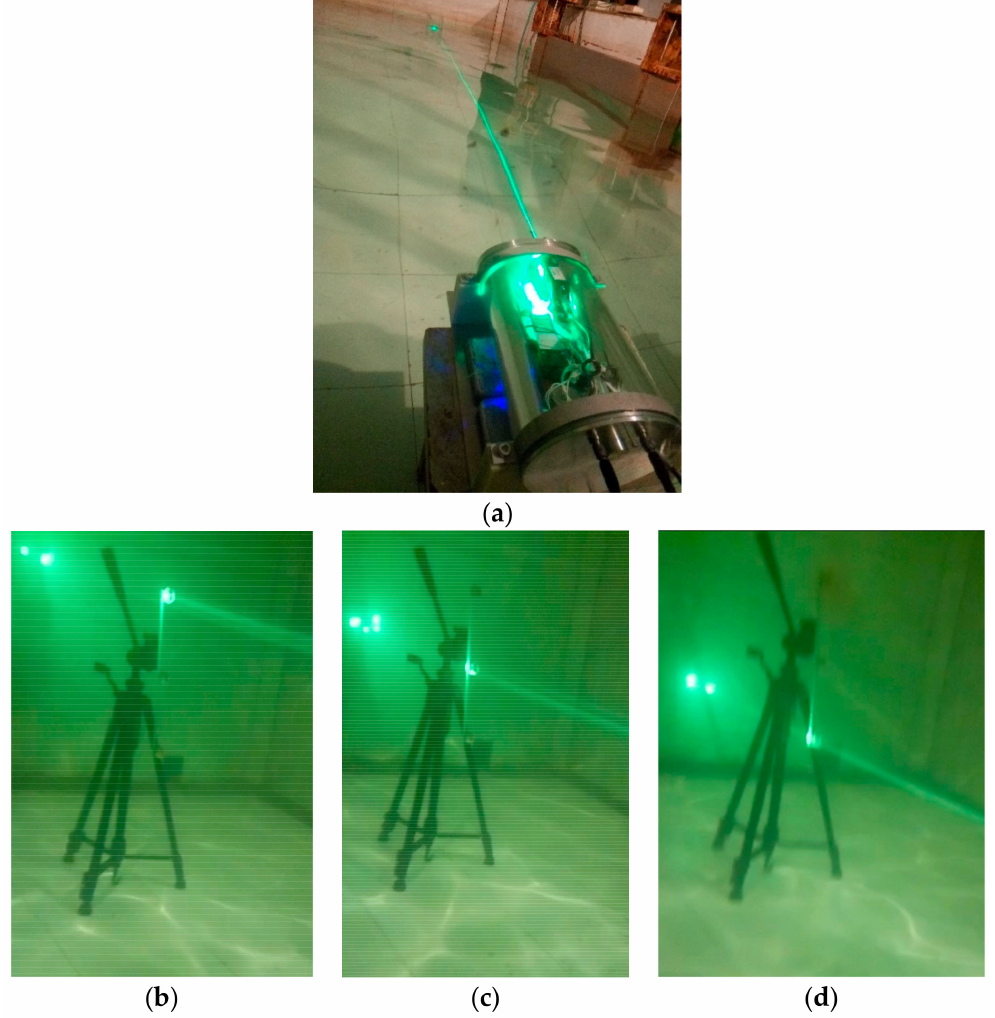
Figure 16. Tracking and localization experiment in the pool. ( a ) The base station emits laser beams and tracks the CRR; Bottom panels show the laser-tracking links of ( b ) 1# CCR (top CCR); ( c ) 2# CCR (middle CCR); and ( d ) 3# CCR (bottom